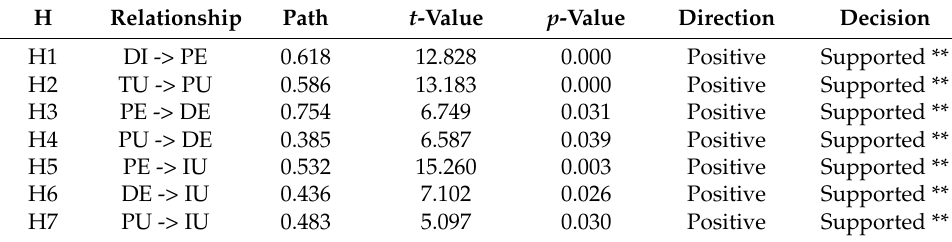
Figure 2. Path coefficient of the model (significant at ** p < = 0.01, * p < 0.05). Table 8. Hypotheses testing of the research model (significant at ** p < = 0.01, * p <